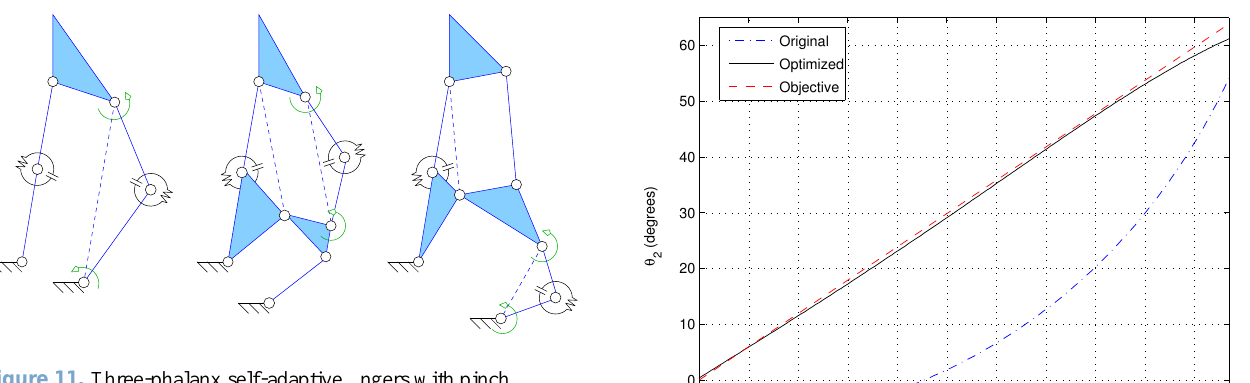
Figure 11. Three-phalanx self-adaptive fingers with pinch preshaping.